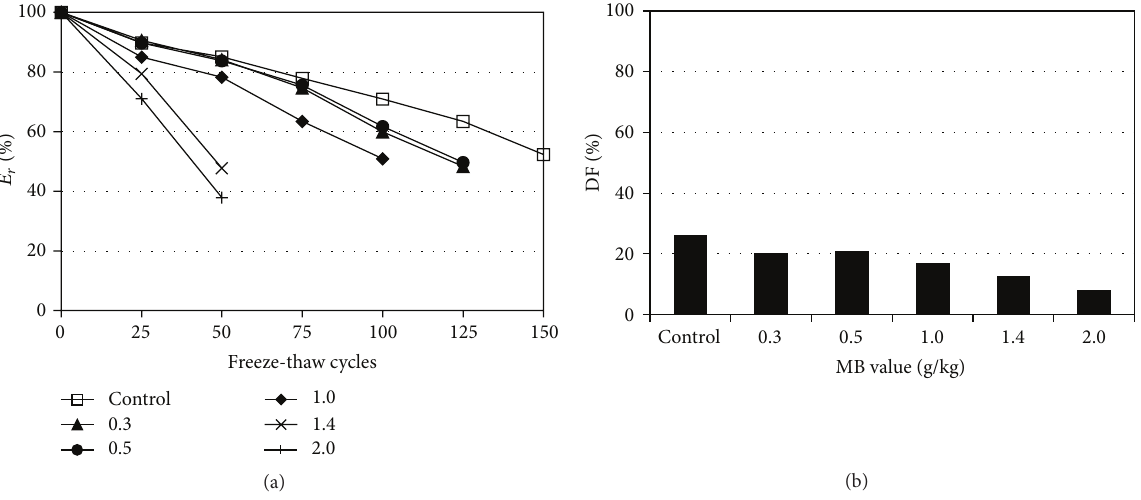
Figure 5: Effect of MB value on frost durability of C30 CSC: (a) 𝐸 𝑟 . (b) DF.